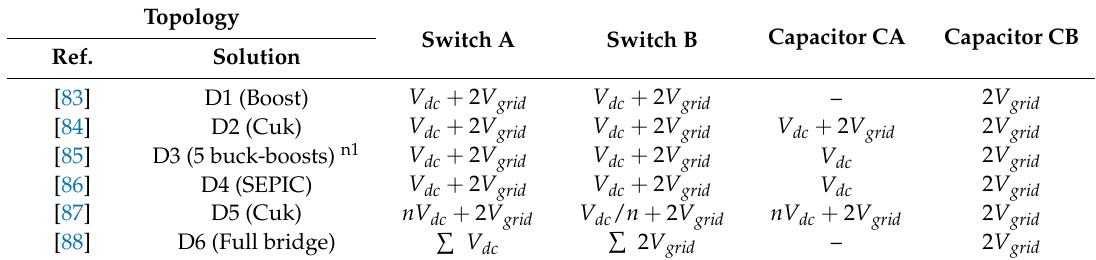
Table 2. Performance voltage stress for selected topologies of di ff erential microinverters.